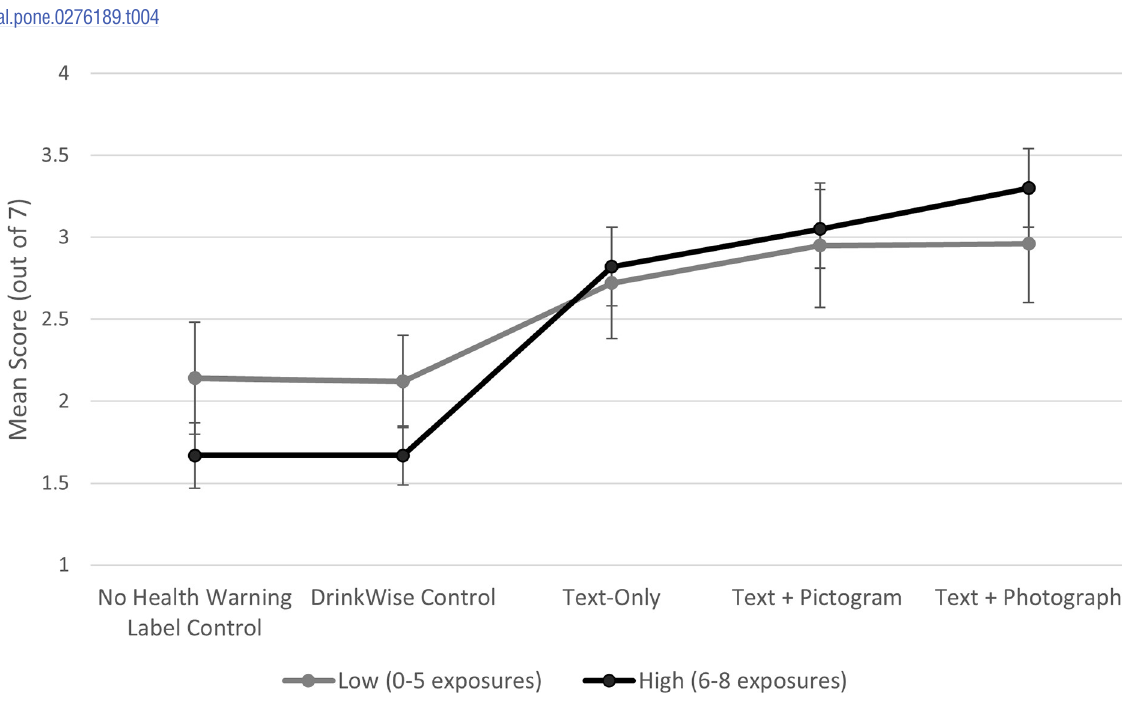
Fig 3. Adjusted means for negative emotional arousal by condition type and dose of repeated exposure ( N = 1 , 087 ).